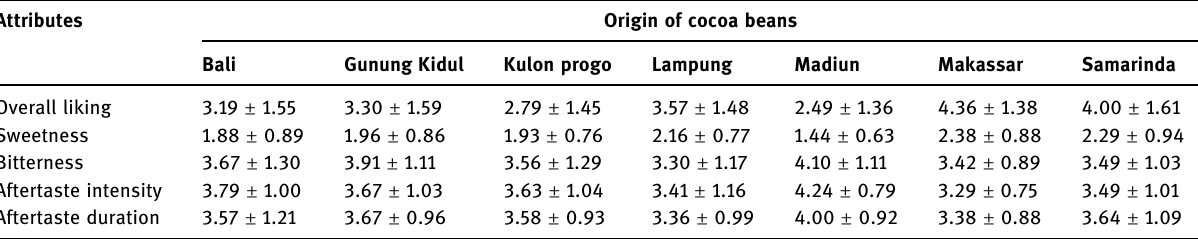
Table 5: Evaluation of overall liking and sensory attributes of chocolate prepared using the dynamic roasting Attributes